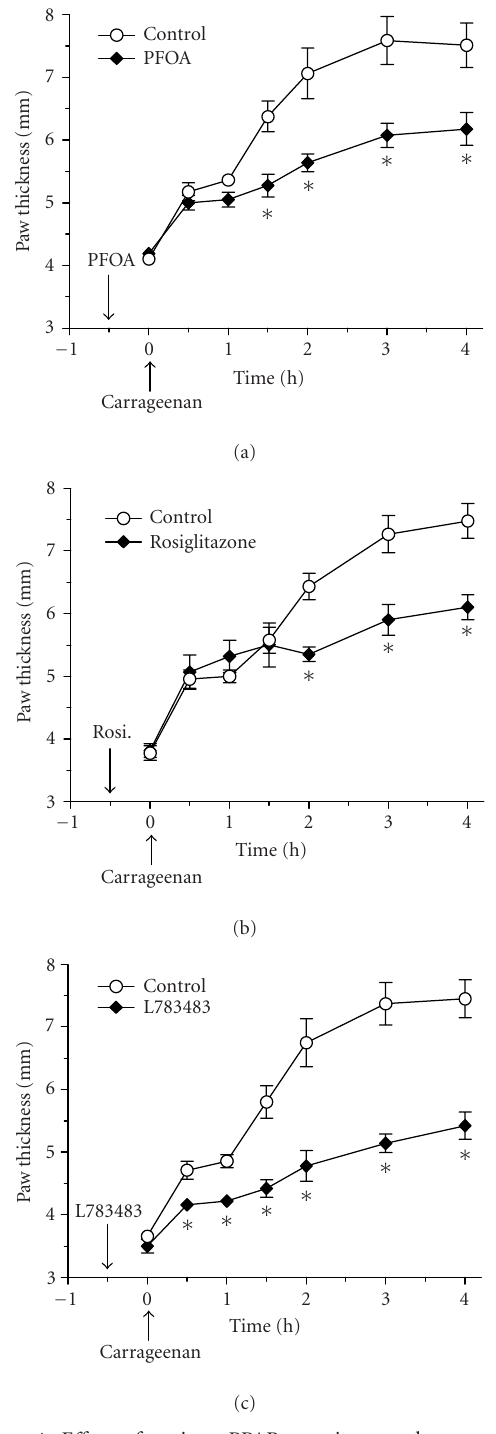
Figure 4. E ff ect of various PPAR agonists on the temporal profile of paw edema. Rats were treated intraperitoneally with (100mg/kg) of the PPAR α agonist PFOA (a), the PPAR γ ag- onist rosiglitazone (b), or the PPAR δ agonist L783484 (c) 30 minutes before induction of inflammation. As indicated by the arrow, carrageenan (1%, intraplantar) was injected at t = 0. Carrageenan-induced edema is reflected by an increase in paw thickness. Values represent mean ± SEM, n = 5–8 rats per group; ∗ P < .